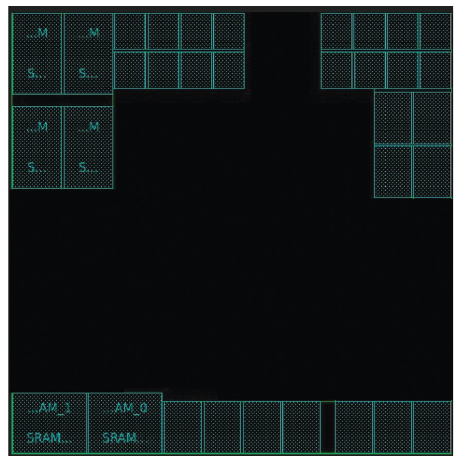
Figure 1: Simulated architecture.